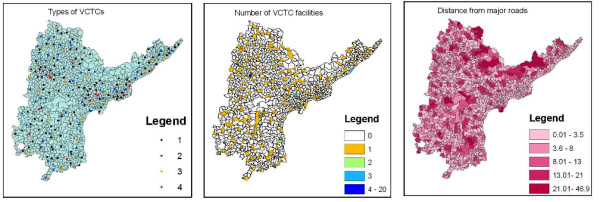
layersA. Layers of the explanatory variables generated for establishing spatial relations.